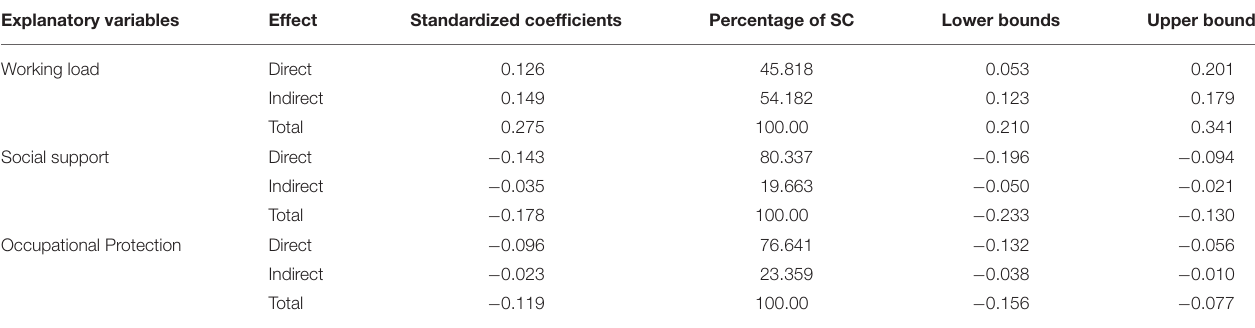
TABLE 3 | Decomposition of mediating effects of fatigue for the structural